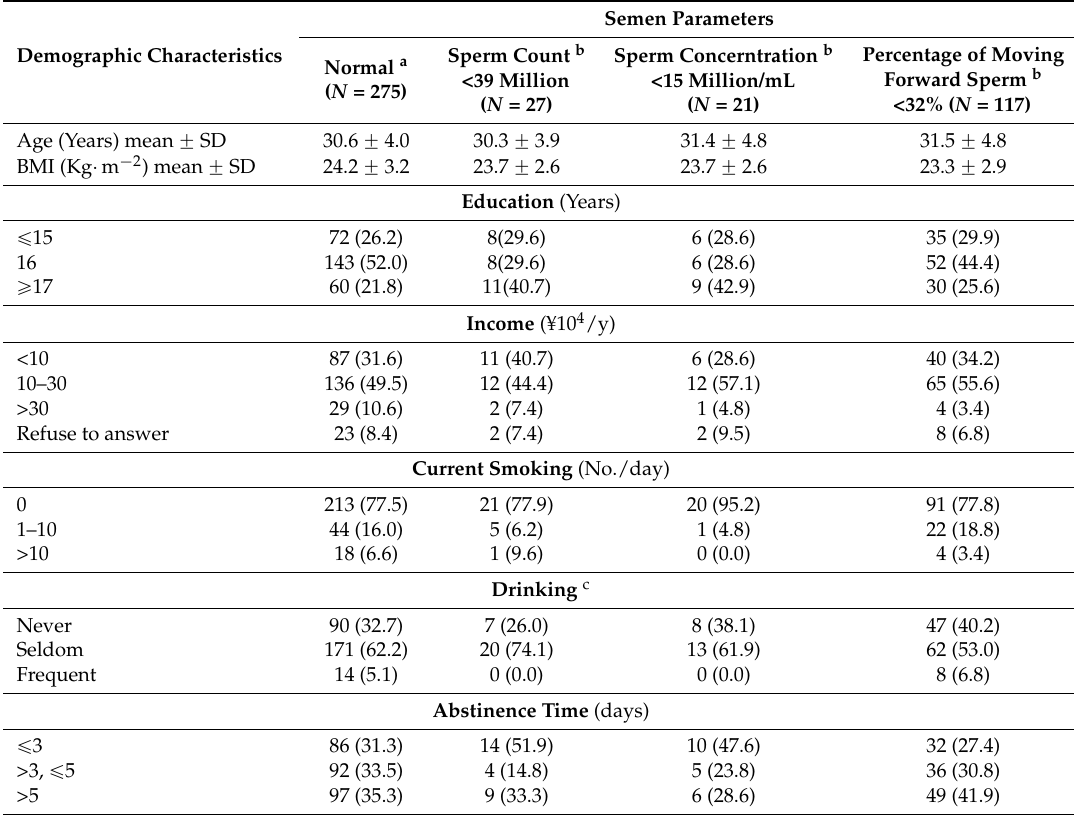
Table A3. Distribution of baseline characteristics by semen